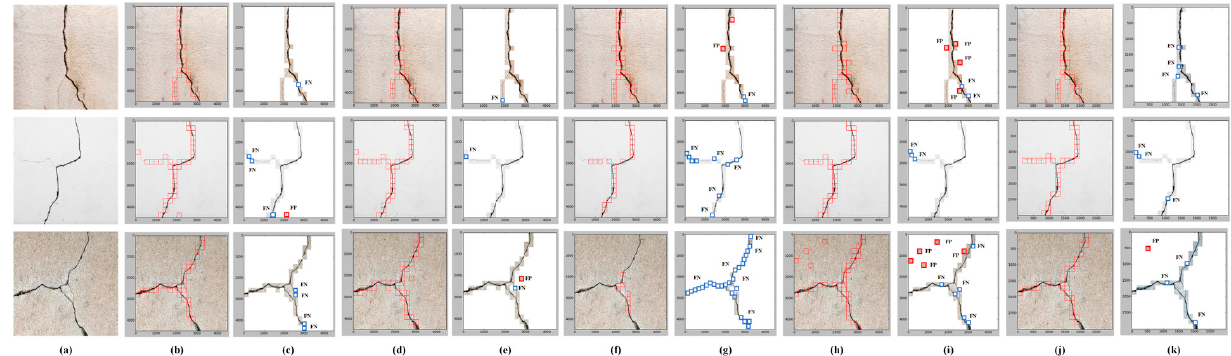
Figure 11. ( a ) Original images. ( b ) Crack localization using VGG-16. ( c ) Screening for false positives (FP) and false negatives (FN) using VGG-16. ( d ) Crack Localization using VGG-19. ( e ) Screening for FP and FN using VGG-19. ( f ) Crack localization using ResNet-50. ( g ) Screening for FP and FN using ResNet-50. ( h ) Crack localization using Inception-V3. ( i ) Screening for FP and FN using Inception-V3. ( j ) Crack localization using CNN. ( k ) Screening for FP and FN using CNN (8.4 k Dataset). The dark blue boxes represent the FN, and red boxes represent the FP regions. Each box in the localization represents a single patch in the test images. We found that the number of FP and FN patches varied in the localization results of all models. The proposed CNN model and VGG-16 models outperformed the other models in terms of localization, as the number of FP and FN patches was less than the other models. The crack